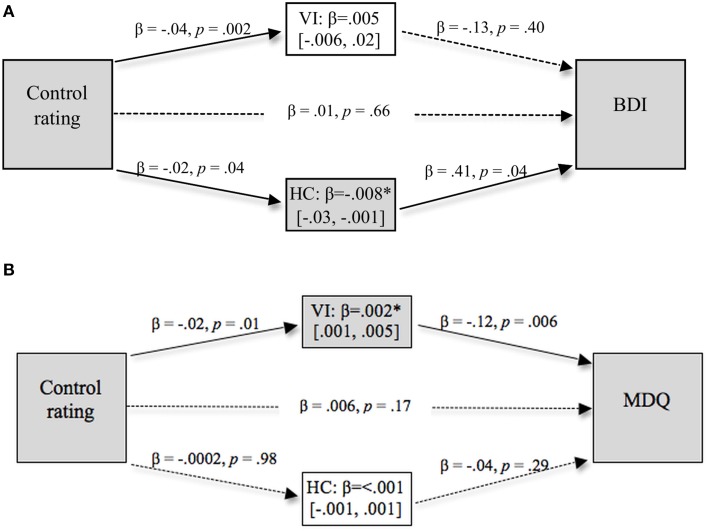
Values as a mediator of the relationship between judgment of control and measures of (A) depression and (B) bi-polar symptoms. Significant indirect pathways are emphasized with gray shading. Ninety-five percentage confidence limits around the indirect effects are shown in brackets.